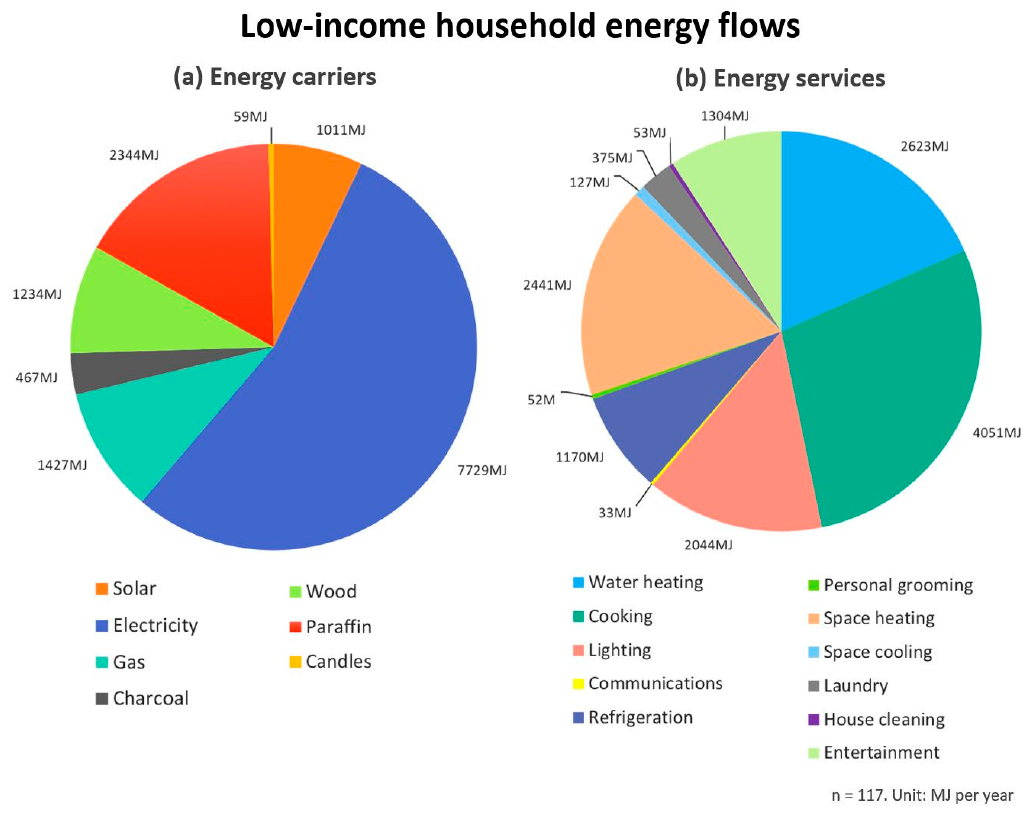
Figure 7. Average carriers and services for low-income households in Cape Town Source: Strydom et al.